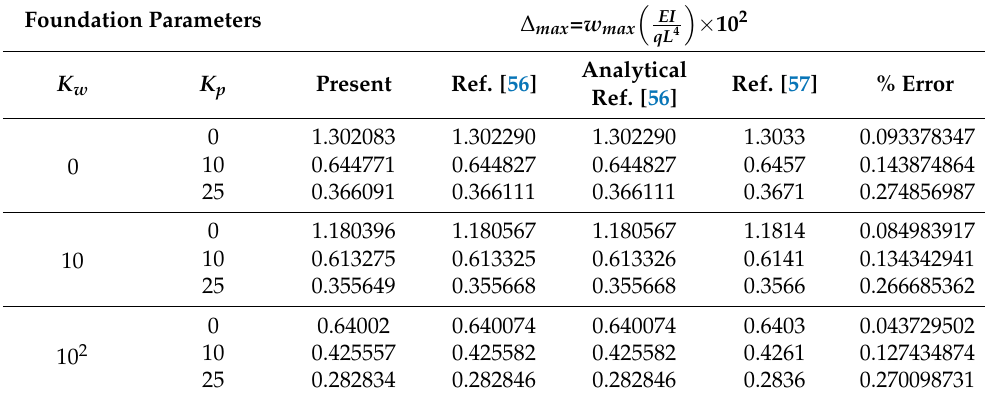
Table 1. Comparison of the estimated maximum classical nondimensional central transverse deflec- tion ∆ max for simply supported (SS) beam embedded in two-parameter elastic foundation under uniformly distributed load of intensity q at beam aspect ratio L / H = 120 at different values of the elastic foundation parameters and Poisson’s ratio ν = 0.3.